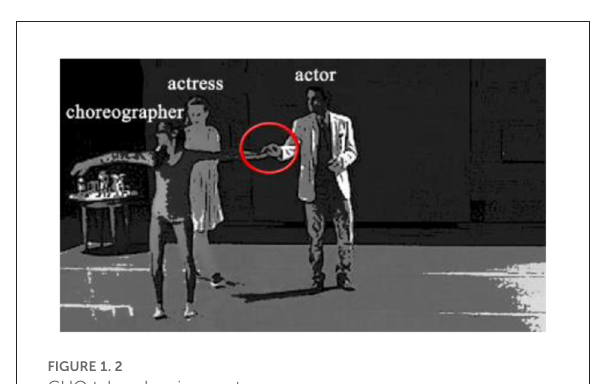
FIGURE1.2 CHO takes dancing